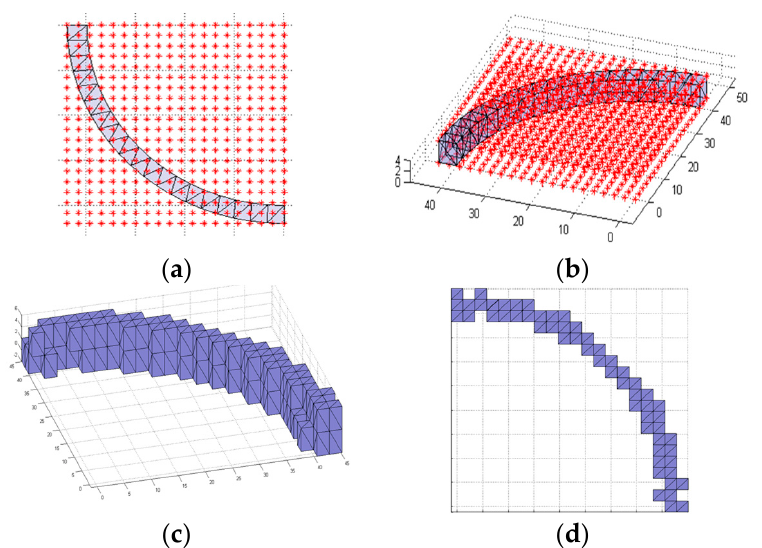
Figure 5. A model contained in a grid ( a ) 2D; ( b ) 3D; ( c ) 3D discretized and voxelized; ( d ) 2D projection of ( c ).